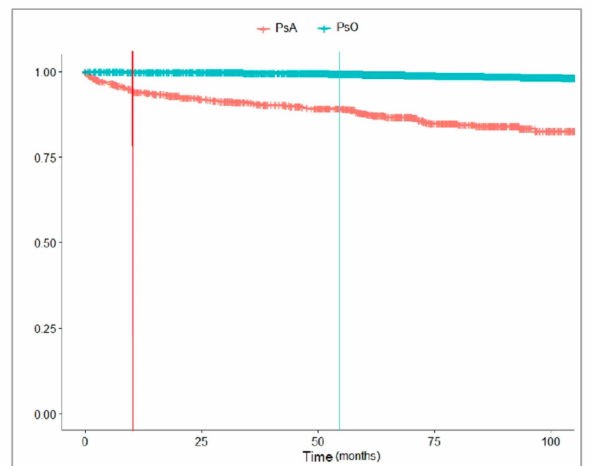
Figure 4. Time (months) from the first registered PsO/PsA diagnosis to the first bDMARD dispensing in the years 2010–2018. Legend: PsA, psoriatic arthritis; PsO, psoriasis.